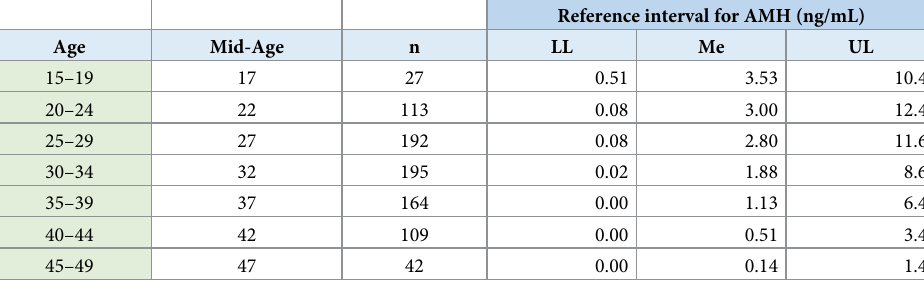
Table 1. Reference intervals of AMH determined for every 5 years of age from 16 to